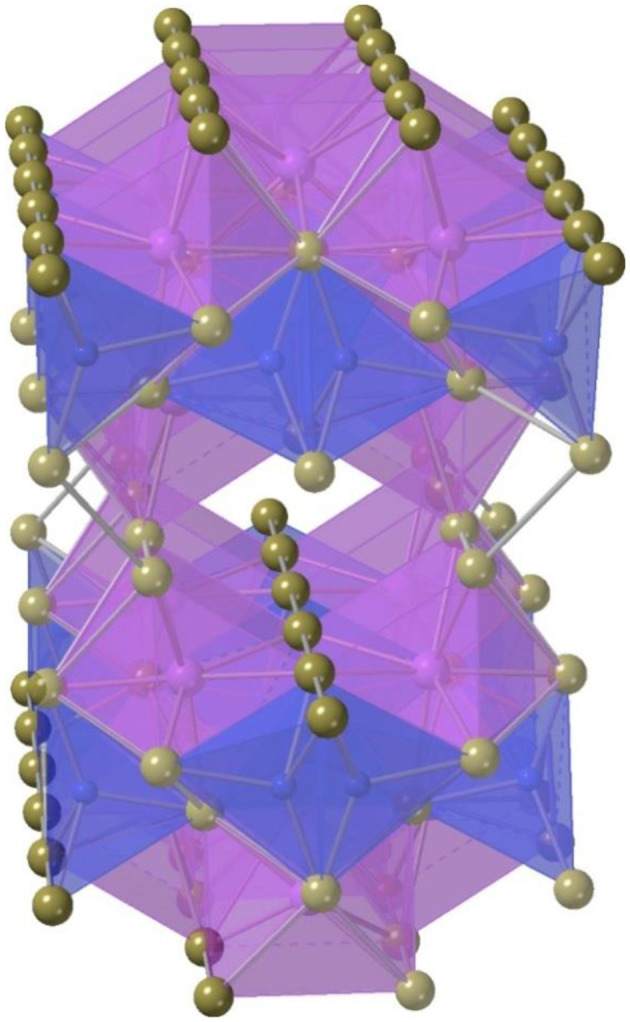
A fragment of Gd3Cu2Te7 structure showing linear Te-Te-Te chains (Huang and Ibers, 2001). Tellurium, gadolinium, and copper are shown in brown, blue, and magenta, respectively.